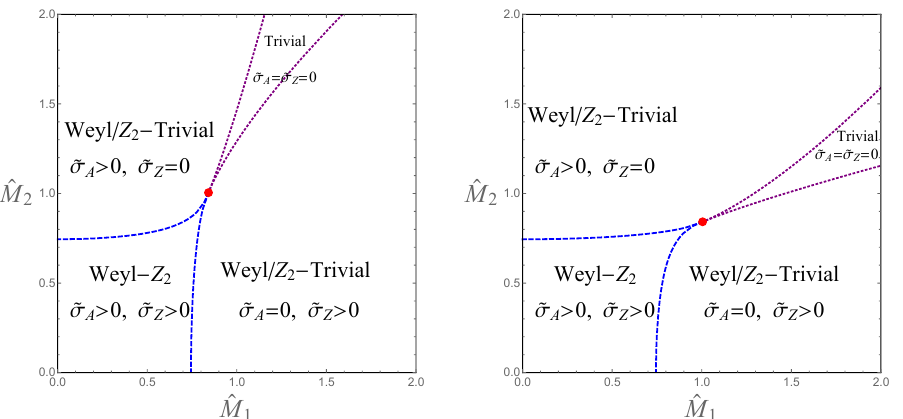
Figure 8. The phase diagram of the holographic system at c/b = 1 / 2 (left) and c/b = 2 (right)